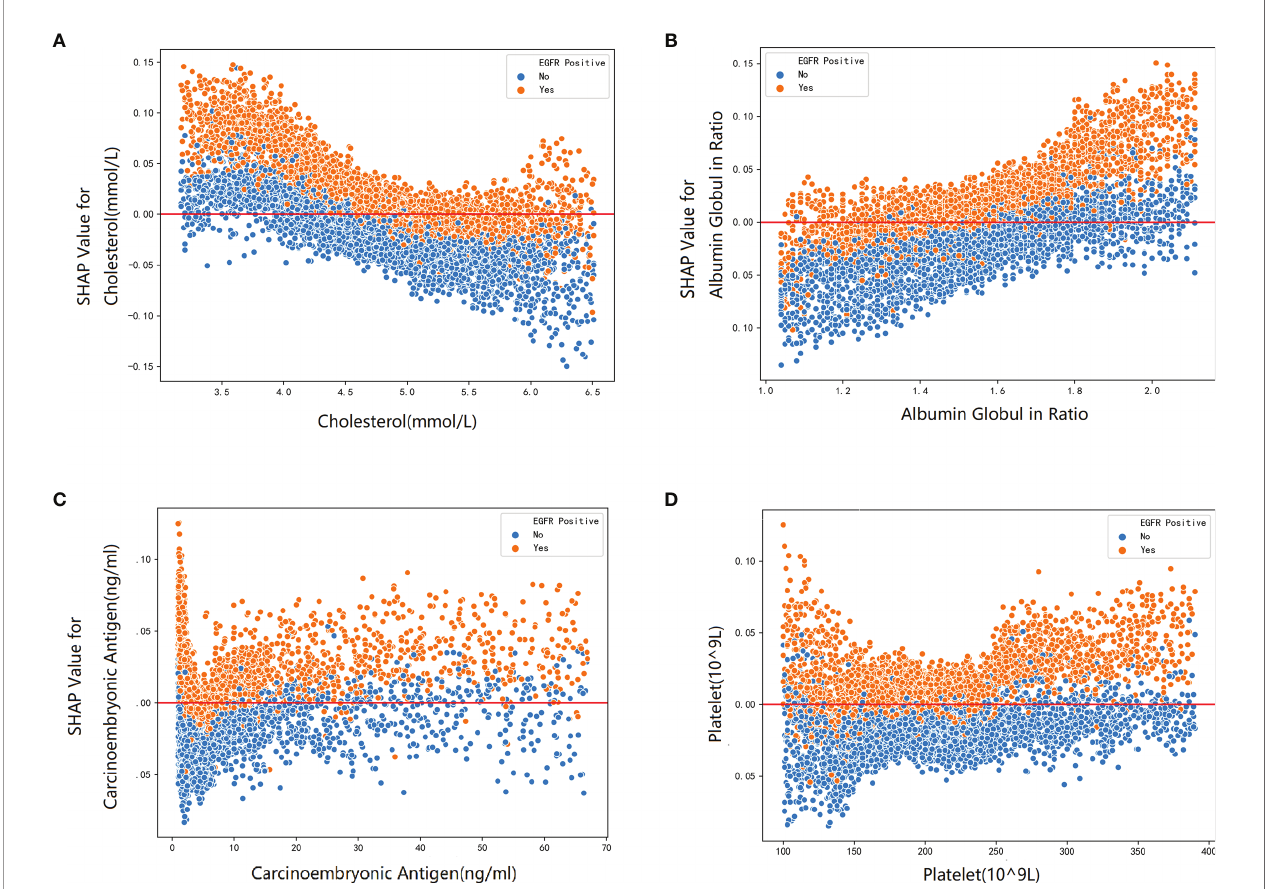
FIGURE 5 | The SHAP dependence plot about blood markers: (A) cholesterol, (B) albumin globulin ratio, (C) carcinoembryonic, and (D)